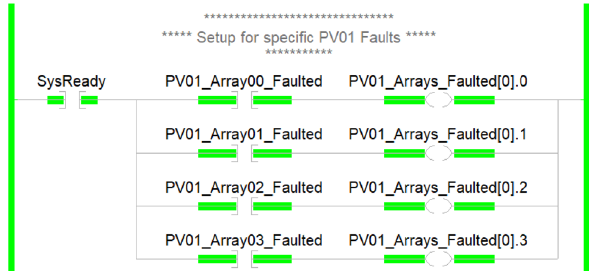
Fig. 4 Alarms setup for every fault related to PV01 group